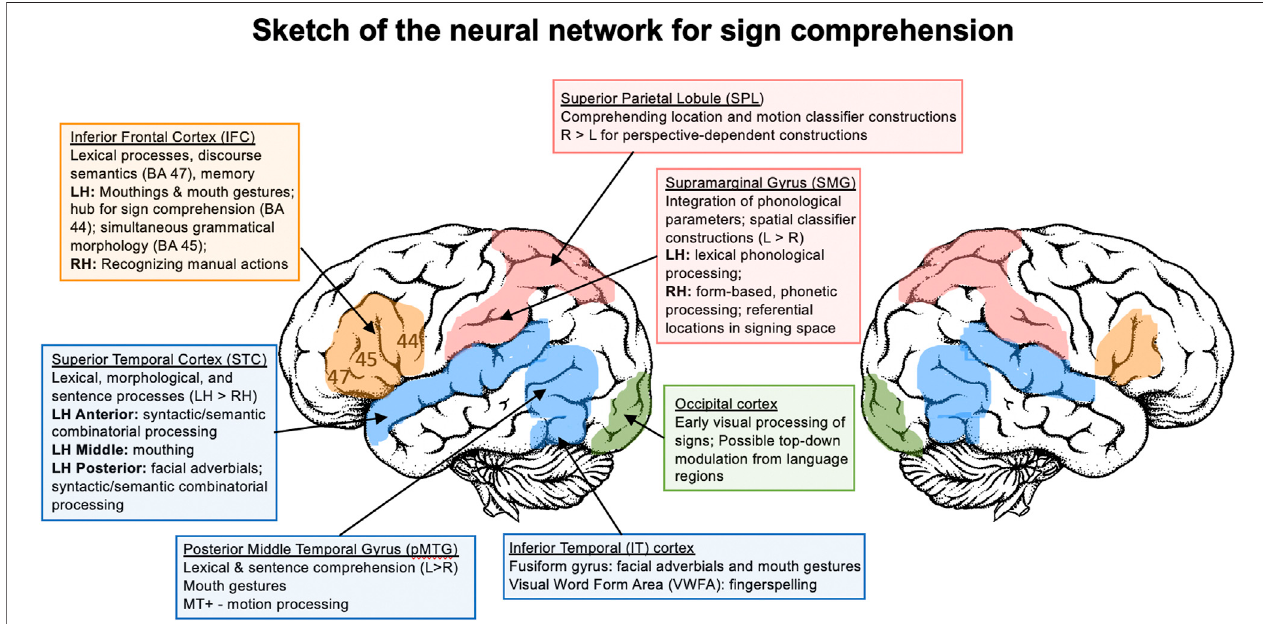
FIGURE 2 | A sketch of the neural network that supports the comprehension of sign language. LH (cid:1) left hemisphere; RH (cid:1) right hemisphere.